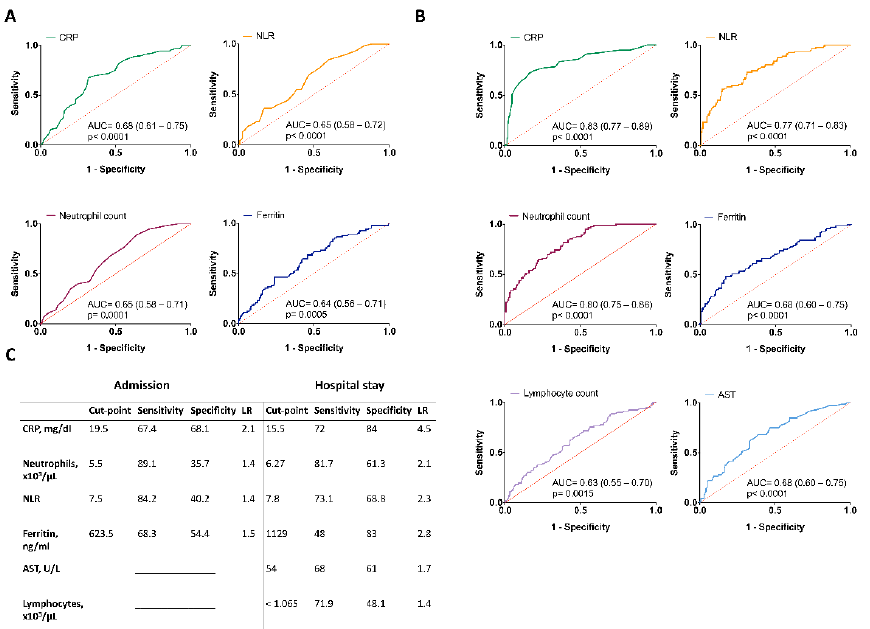
Figure 3. ROC curves of laboratory markers for COVID-19 mortality. ( A ) Data obtained upon hospital admission. ( B ) Data obtained upon hospitalization. ( C ) Summary of cut-off values, sensibility, specificity, and likelihood ratio.